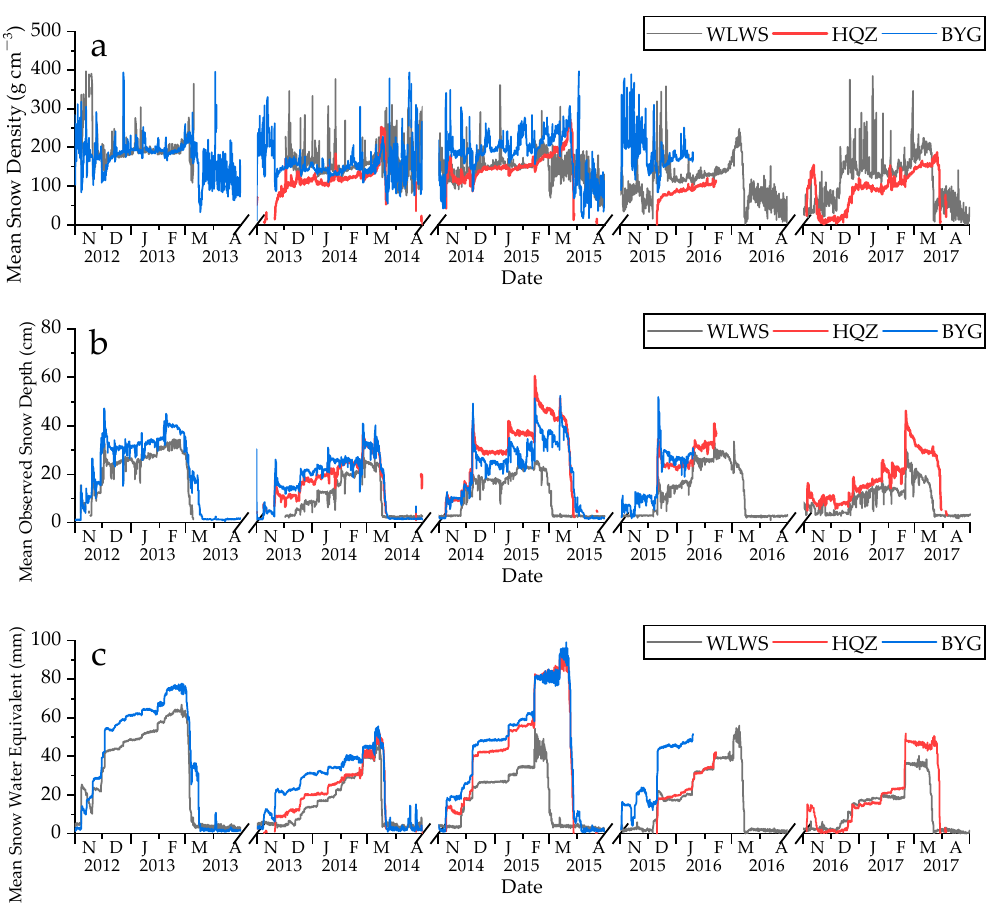
Figure 2. Time series of snow water equivalent (SWE), snow density, and snow depth for 3-h time steps at the three automatic snow stations for five winter periods from 1 November to 30 April, 2012– 2017.